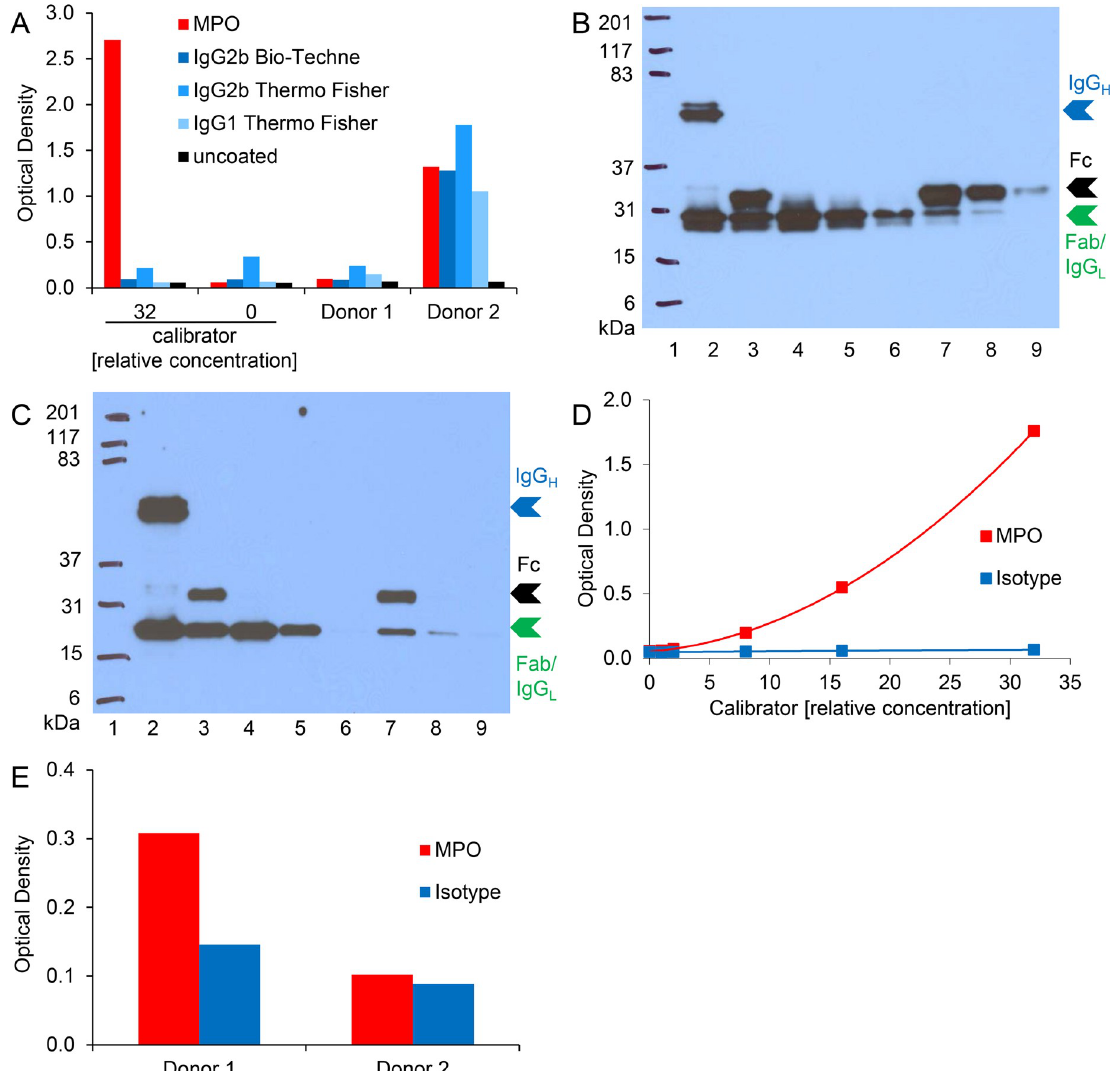
Fig 4. Cross-reactivity of plasma components in MPO-DNA ELISA is observed for various mouse IgG isotypes. A) Microwells were coated with MPO antibody, various isotype controls or were left uncoated. Calibrator or 1:2 diluted plasma samples were analyzed according to the initial MPO-DNA complex ELISA protocol. The calibrator with a relative concentration of “0” equals blank. B) MPO antibody (Bio-Rad) and C) isotype control (IgG2b, Bio-Techne) were processed to Fab and Fc fragments. Western blot analysis after reducing SDS-PAGE (12.5% gel) of unprocessed antibodies (lane 2), papain cleaved unpurified antibodies (lane 3), purified Fab fragments (fractions 1–3, lanes 4–6) as well as Fc fragments (fractions 1–3, lanes 7–9) are depicted. Molecular weight marker (Kaleidoscope ™ Prestained Standard) was applied in lane 1 and is given in kDa. Intact immunoglobulin G heavy chains (IgG H ) in lane 2 and the respective Fc and Fab fragment chains in lanes 3–9 are indicated with blue, black and green arrowheads, respectively. Please note that the immunoglobulin G light chain (IgG L ) remains unaltered by the fragmentation process and has a molecular weight close to the fragmented Fab heavy chain. Hence, the two protein bands could not be resolved and are both indicated by the green arrowhead. D) and E) MPO antibody and isotype control (for both: Fab fragment, fraction 1) were coated onto microwells and incubated with D) serially diluted calibrator or E) 1:2 diluted plasma samples. The further ELISA procedure was performed as indicated for the initial MPO-DNA complex ELISA